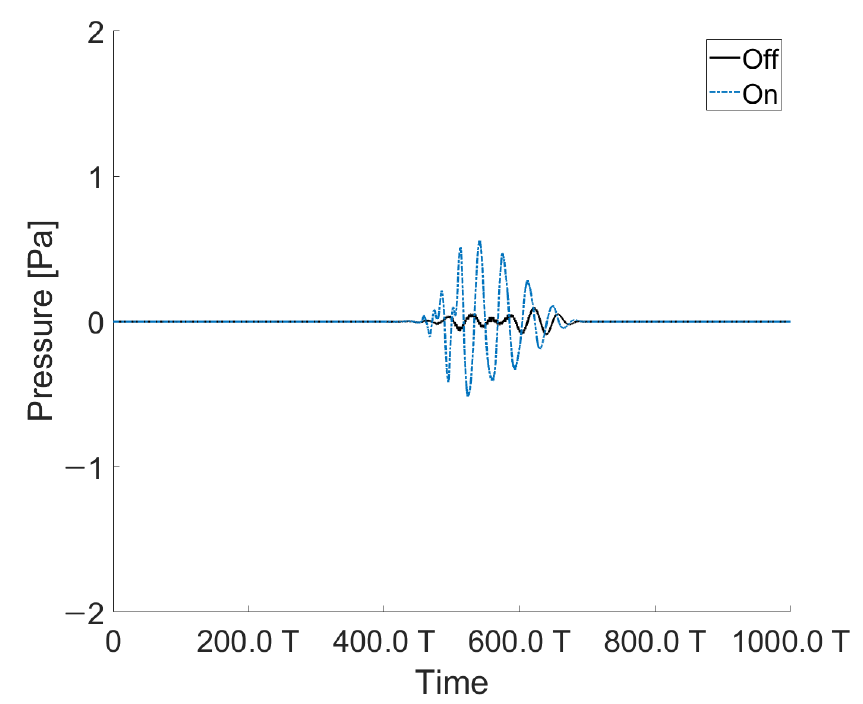
Figure 12. Acoustic signal measured by the hydrophone located in the perpendicular direction (RX 1) of the controller (at 10°).